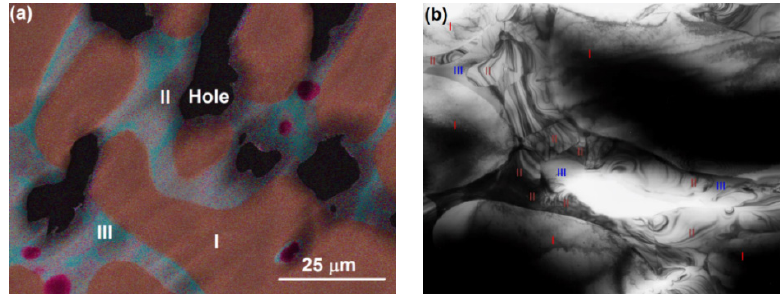
Figure 6. ( a ) SEM image for TEM touring and ( b ) low-magnification bright field TEM image